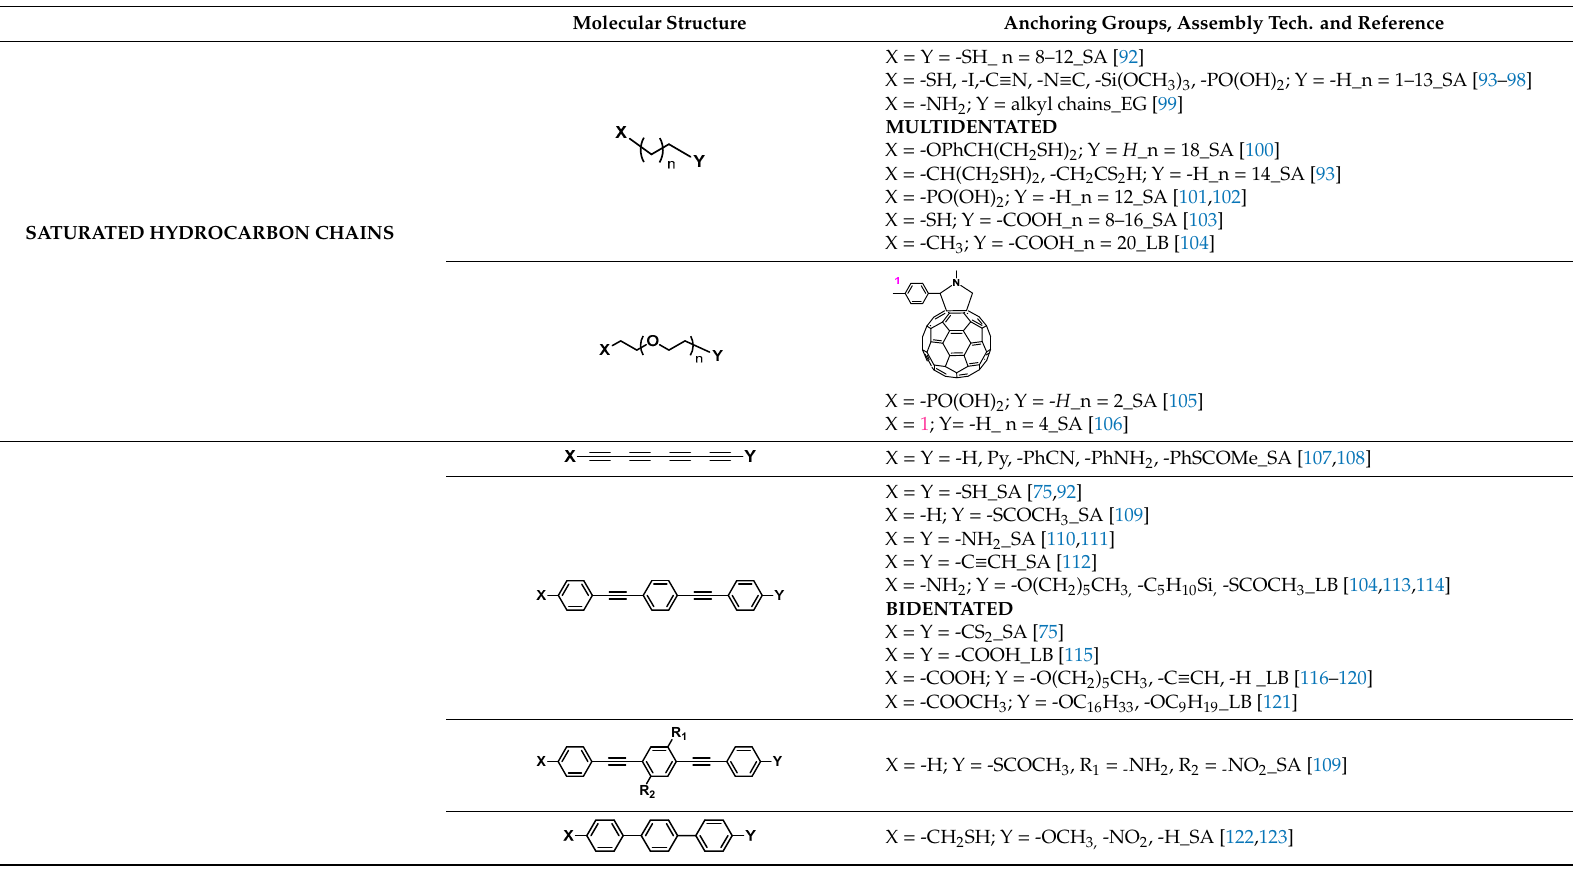
Table 1. Illustrative examples of molecular skeletons and anchor groups of the main families of materials used to fabricate molecular films in the field of molecular electronics. Molecular Structure Anchoring Groups, Assembly Tech. and Reference